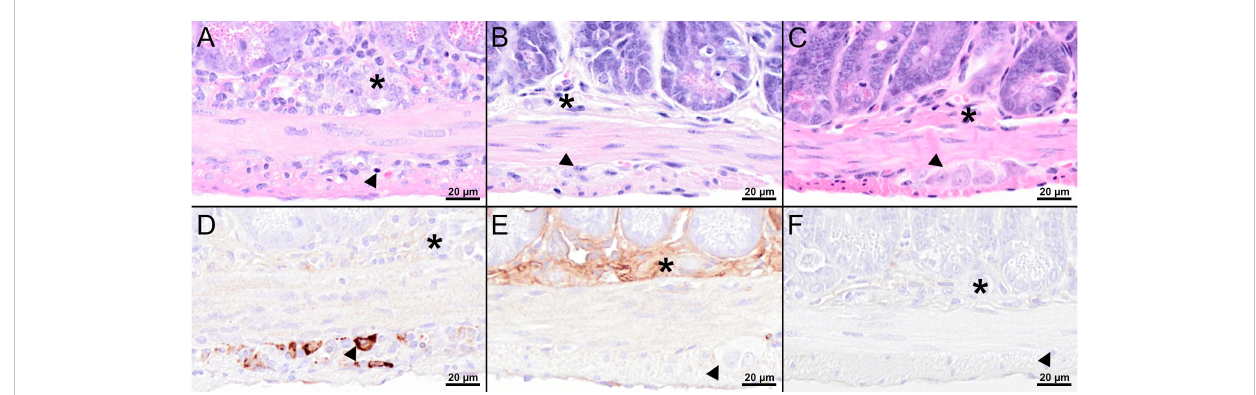
FIGURE 6 Histological and immunohistochemical analyses of the jejunum at 8 dpi. (A – C) H&E-stained sections of the jejunum of TBEV-infected mice which were either treated with PBS (A) or vaccinated with FSME-IMMUN ® (B) or MVA-prME (C) . (A) Marked hypercellularity/in fl ammatory cell in fi ltrates in the submucosal plexus (asterisk) and, to a lesser extent, in the myenteric plexus (arrowhead) as well as cellular necrosis with karyorrhectic, karyolytic, and pyknotic cells (arrowhead) are present. (B, C) No signi fi cant microscopic lesions within the submucosal (asterisk) and myenteric plexus (arrowhead) are present in vaccinated mice. (D – F) IHC for TBEV E antigen of the jejunum of TBEV-infected mice which were either treated with PBS (D) or vaccinated with FSME-IMMUN ® (E) or MVA-prME (F) . (D) Immunohistochemically, TBEV-positive neurons are observed in the myenteric plexus (arrowhead) but not in the submucosal plexus (asterisk). (E, F) No immunopositive cells are present in the submucosal (asterisk) or myenteric plexus (arrowhead). Band-like, not cell-associated, brownish discoloration in (E) represents a staining artifact due to the unspeci fi c binding of the antibody to serum components. Scale bars: 20